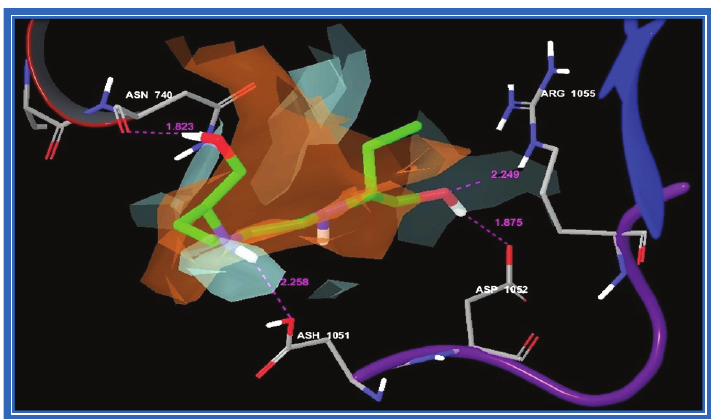
Figure 1: Binding orientation of most stable conformer ( Δ𝐺 regions around the binding site are shown in cyan and orange, respectively.